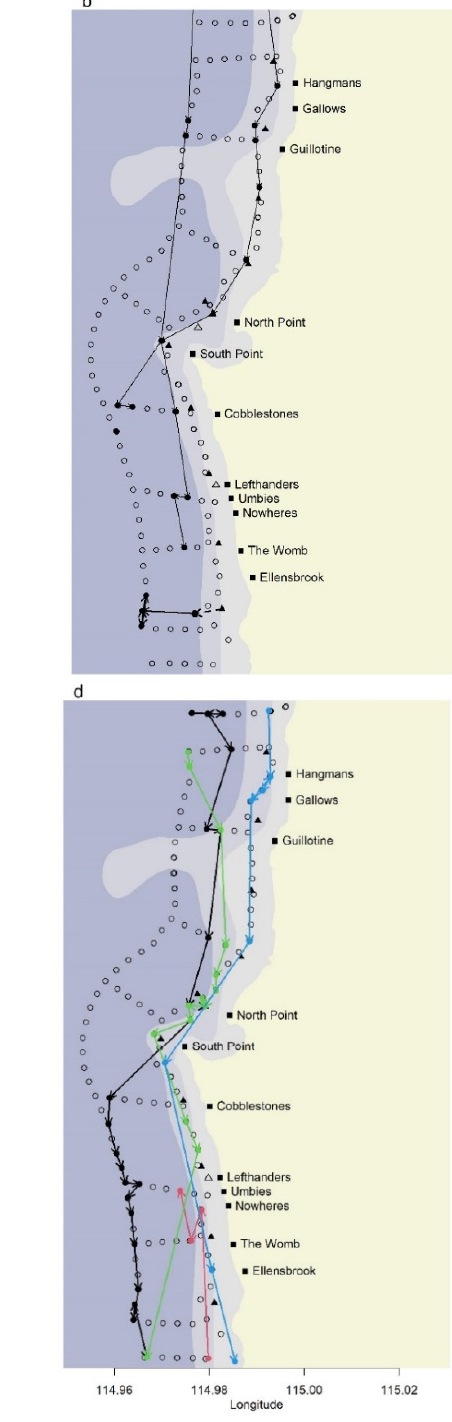
Figure 3. Location of VR2 (open dots) and VR4 (open triangles) receivers off Gracetown with major surf breaks (black squares) and SMART drumline locations (filled triangles) indicated. Arrows are inferred straight-line movements for sharks between successive detection locations (solid dots). Relocation paths (dashed line) to release points and detections (solid dots) are presented for: ( a ) white shark 1; and ( b ) white shark 2. All acoustically tagged white sharks that were detected within the Gracetown array while SMART drumlines were being actively fished are presented in ( c , d ) with colours denoting separate movements through the array.